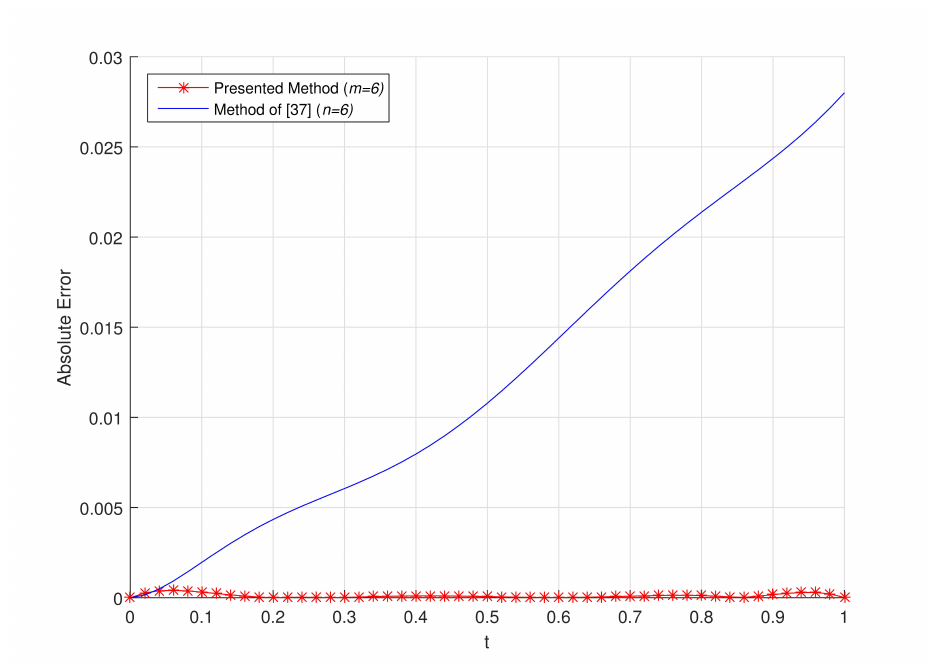
Figure 4. The behaviour of absolute errors obtained by using proposed method and the method of [59] with m , n =